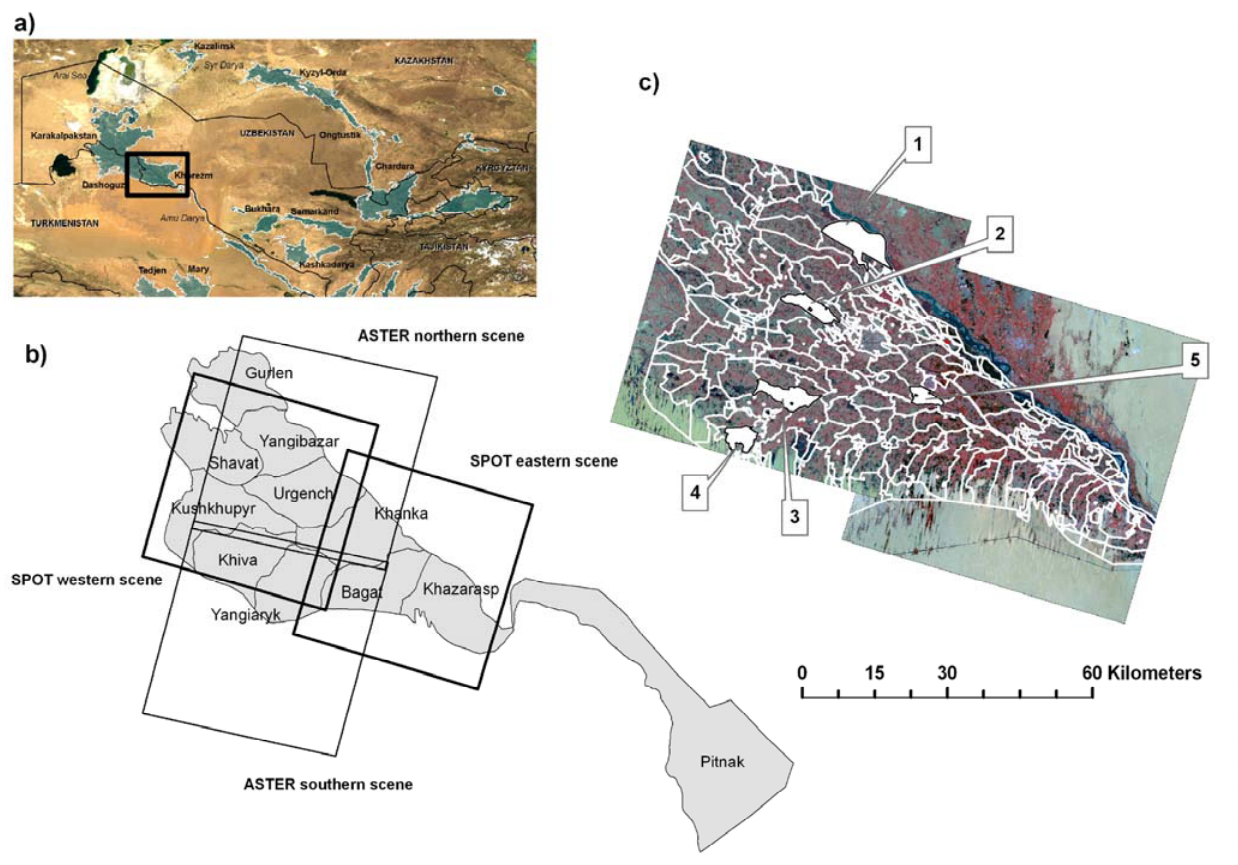
Figure 1. The study area. (a) Countries and irrigation regions of Central Asia. The Khorezm region is highlighted. (b) Administrative boundaries of the Rayons in the Khorezm region and the extent of the satellite images used in this study. (c) Boundaries of the Water User Associations (WUAs) in Khorezm. The SPOT 5 scenes used in this study are displayed in the background. Highlighted are the WUAs that are investigated in